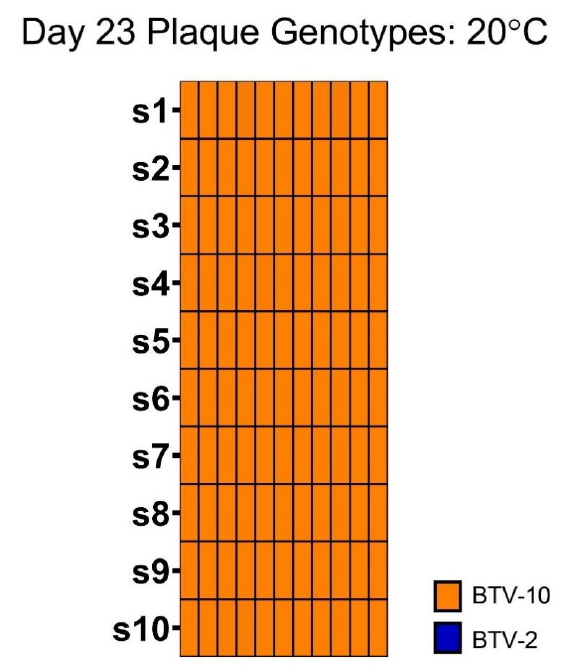
Figure 6. Genotype of plaques isolated from BTV-2+10 co-exposed midges at day 11 post-blood meal. Plaque genotypes from plaque isolated viruses from pools of BTV-2+10 exposed midges collected on day 11 post-infection as detected via amplicon-based sequencing. Each column represents the full 10 segments of an individual plaque (s1 through s10) in descending order. Only plaques where the complete genotype could be determined are depicted here. Plaques where sequencing reads were very low or where multiple segments did not receive reads are not included. In some cases where only segment 2 was not detected via amplicon sequencing, BTV serotype-specific qRT-PCR was used to determine the identity of the segment. Plaques isolated from midges held at different temperatures (20, 25, 30 °C) are demarcated by white margins.